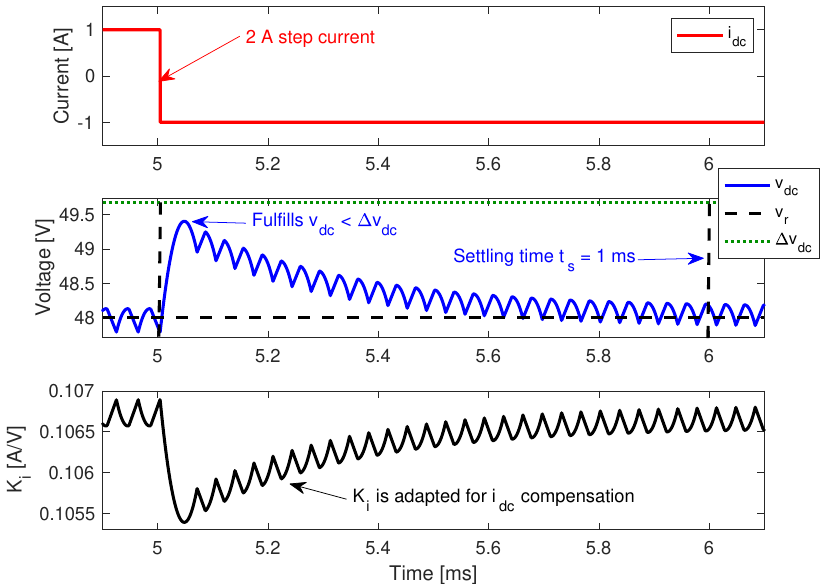
Figure 14. Performance in the compensation of the bus